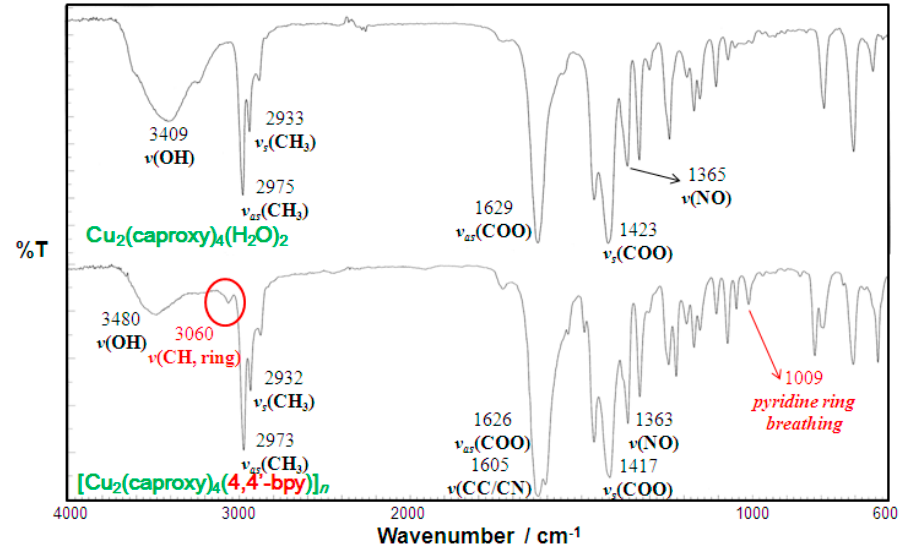
Figure 3. Infrared spectra of [Cu 2 (caproxy) 4 (4,4 ′ -bpy)] n ( 3 ) compared with those of the parent compound ( 1 ). Table 2. Infrared spectral data of [Cu 2 (catempe) 4 (H 2 O) 2 ] ( 2 ) and chain compounds [Cu 2 (catempo) 4 (L)] L = 4,4 ′ -bpy ( 9 ), bpe ( 10 ), bpel ( 11 ), pds ( 12 ), and dabco ( 13 ).